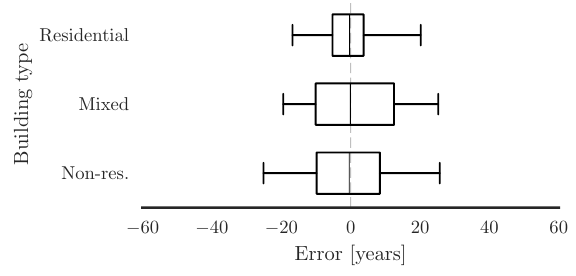
Figure 9. Errors by type of building in model 2. The decom- posed errors reveal varying accuracy depending on the type of the